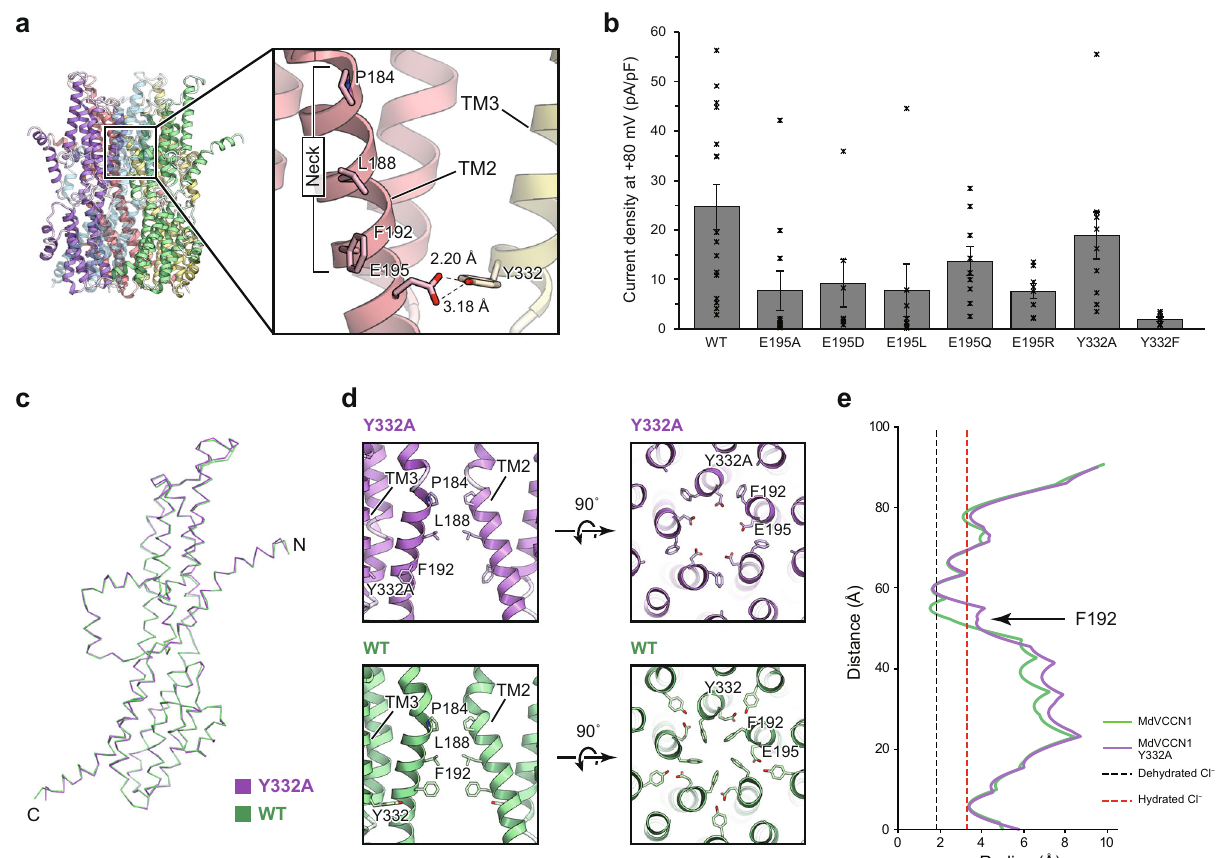
Fig. 5 The hydrogen bond between Glu195 and Tyr332. a Close-up view of the neck and the hydrogen bond between Glu195 and Tyr332. b Whole-cell current densities at + 80 mV in HEK293 cells expressing MdVCCN1 wild-type, Glu195 mutant, or Tyr332 mutant (wild-type ( n = 16), E195A ( n = 11)], E195D ( n = 7), E195L ( n = 8), E195Q ( n = 9), E195R ( n = 8), Y332A ( n = 10), Y332F ( n = 7)). Error bars represent s.e.m. Source data are provided as a Source Data fi le. c Comparison of C α traces of the MdVCCN1 Y332A mutant (violet) and wild-type (green). d Neck structures of the MdVCCN1 Y332A mutant (upper panels) and wild-type (lower panels), in which the left panels are views from the side and the right panels are from the top. e Pore radii of the MdVCCN1 Y332A mutant (violet) and wild-type (green) along the center axis of the channels. Black and red dashed lines represent the radii of dehydrated and hydrated Cl − ,